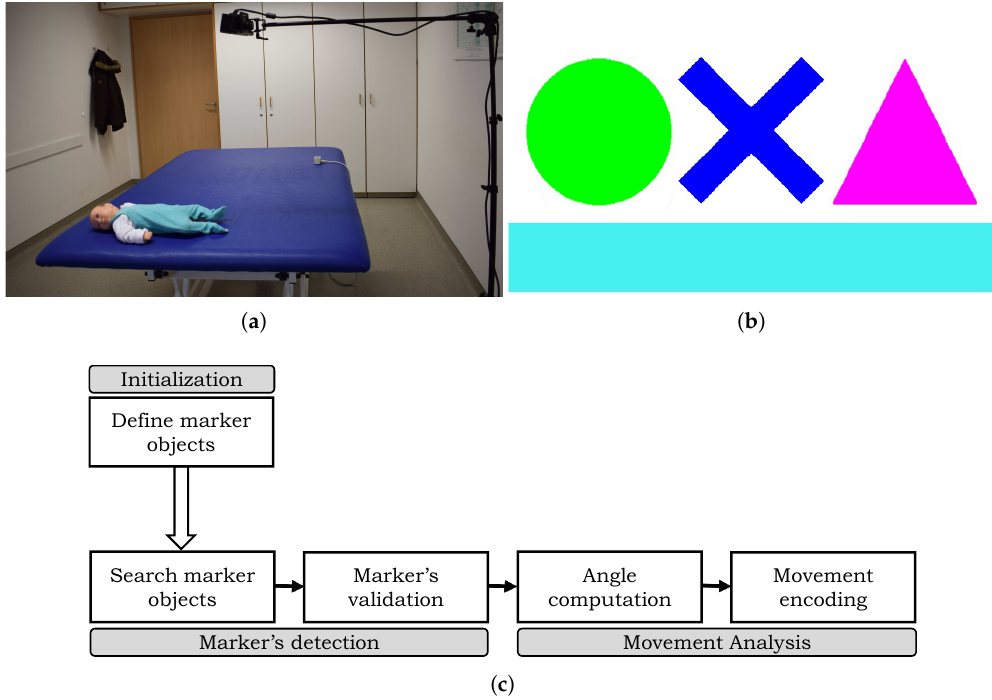
Figure 3. Proposed method ( a ) an illustration of the hardware system components, ( b ) selected color markers with predefined geometric shapes of circle, cross, triangle and bar, and ( c ) block diagram of the proposed